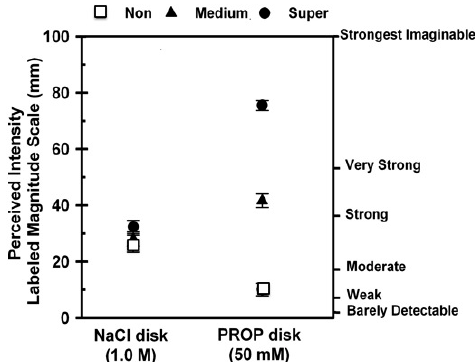
Figure 3. Classification of 93 lean women, 18–45 years of age as PROP non-tasters, medium tasters and super-tasters based on intensity ratings (mean ±95% confidence) for paper disks that were impregnated in PROP (50 mM) and NaCl (1.0 M), and then dried. The PROP disks contained 0.28 mg (±2.2% CV) PROP measured by ethanol extraction. Super-tasters were identified with a cutoff score for PROP bitterness >67 mm on the LMS; non-tasters had a cutoff score ≤ 15 mm. All others were identified as medium tasters. There were no differences in the perception of NaCl across the three subject groups. Data are from Tepper et al. [28] with permission.